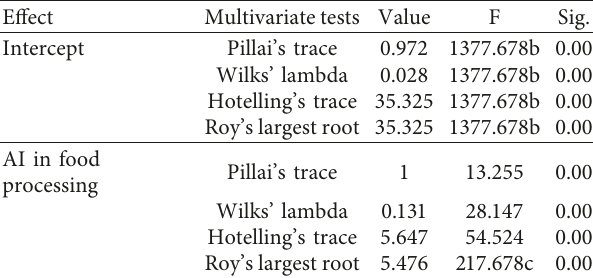
Table 4: Multivariate analysis.